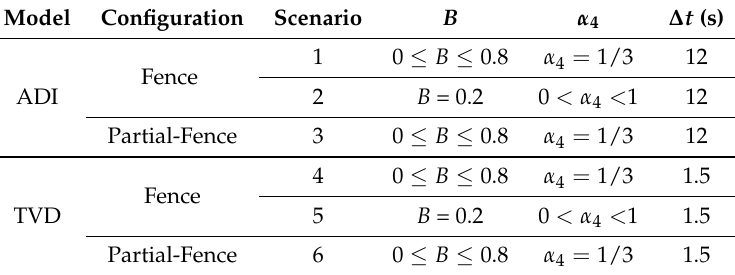
Table 1. Scenarios simulated and initial parameters’